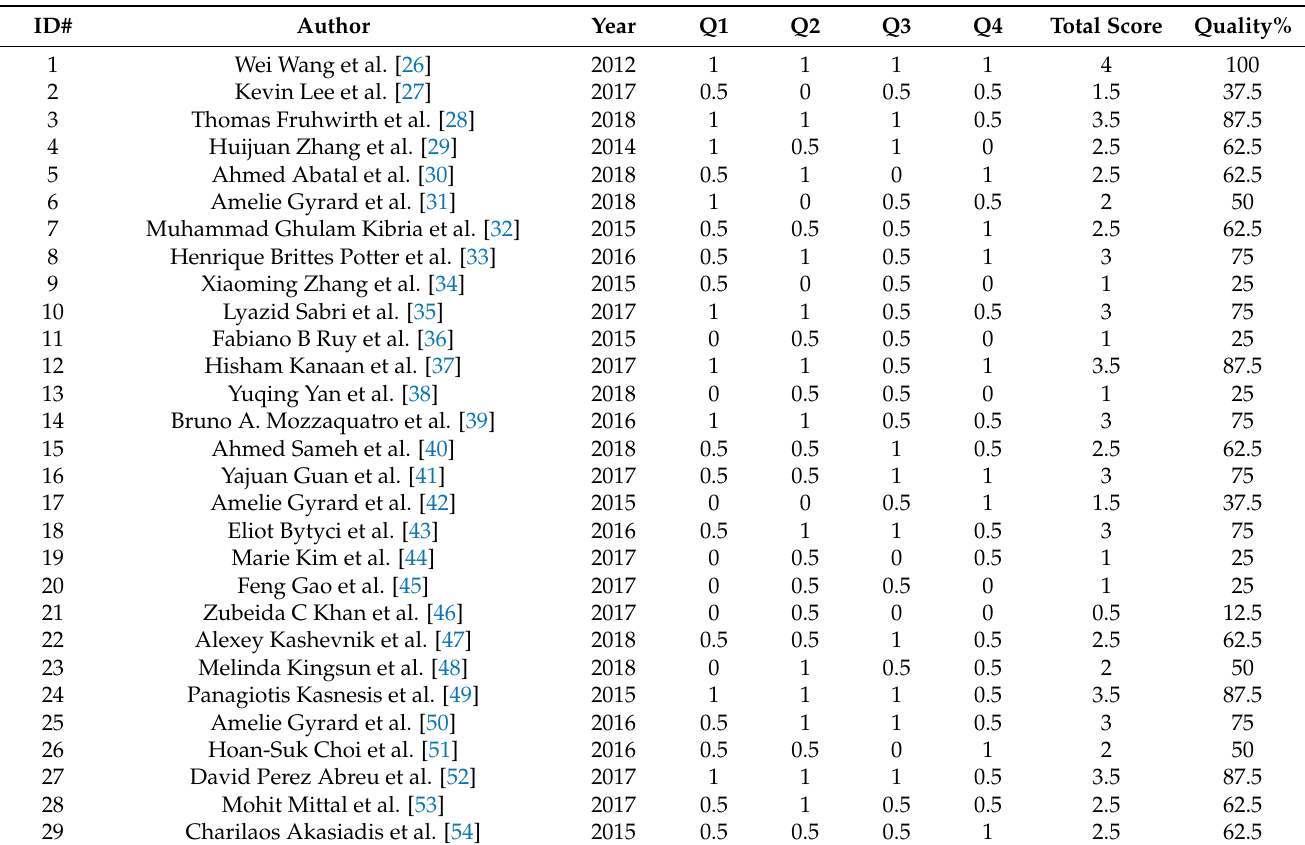
Table 2. Quality scores of the selected papers for the four assessment